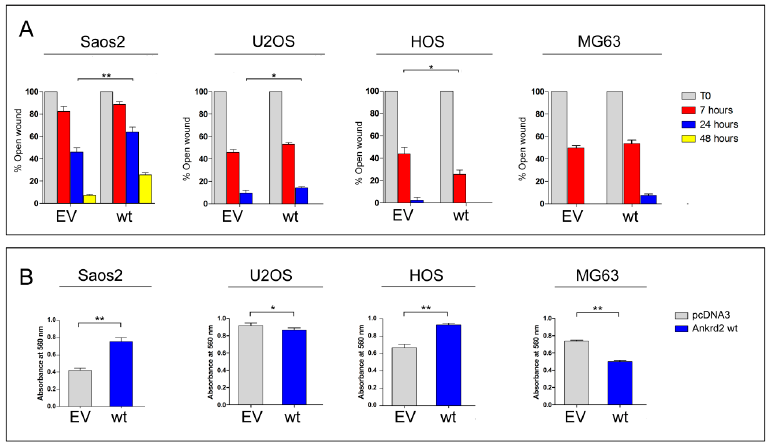
Figure 4. Ankrd2 overexpression affects the motility of human OS cell lines. ( A ) The 90%-confluent monolayers of OS clones overexpressing Flag-Ankrd2wt (wt) or transfected with empty vector (EV) were wounded with a 200 μ L pipette tip. Three “wounds” were formed on each culture dish in duplicate per experiment. Images were acquired by light microscopy at the time of the scratch (T0) and after 7, 24 and, where indicated, 48 h. Measures of the cell free area were taken by the AxioVision software, Feldbach, Switzerland. Data were plotted as the percentage of open wound compared to its original size, at T0, and analyzed using the GraphPad Prism software. Statistical analysis was performed with a paired two-tail Student’s t test. * p < 0.05, ** p < 0.01. ( B ) A total of 3 × 10 4 cells of Saos2, U2OS, HOS and MG63 clones overexpressing Flag-Ankrd2wt (wt) or those that were transfected with empty vector (EV), were loaded into the upper Boyden chamber in serum-free media and assayed for chemotactic potential. After 5 h of culture in the presence of chemo-attractant, cells were stained with crystal violet and the absorbance at 560 nm was measured. Data were analyzed with the GraphPad Prism software. Data are representative of two independent experiments. Statistical analysis was performed using an unpaired two-tail Student’s t test. p < 0.01.